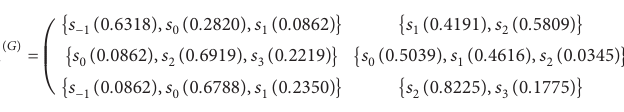
Table 3: The PLDM R ( 3 ) provided by the netizens e